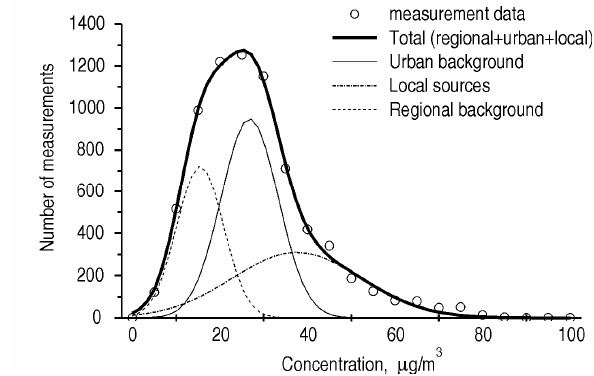
Fig 9 . Frequency distribution of half-hour PM 10 mass concentration in Šiauliai on June–October 2005. The sta- tistical parameters for the Gaussian fits are given in